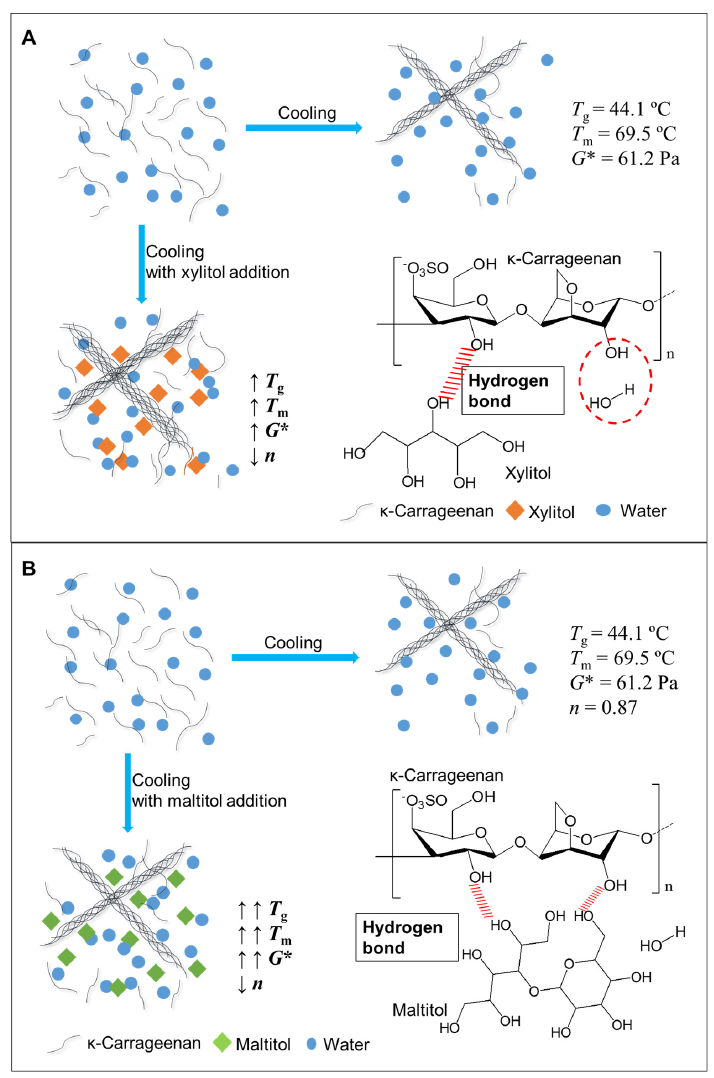
Figure 4. Schematic illustrations of the transition of κ -carrageenan ( κ -C) gels as impacted by xylitol ( A ) and maltitol ( B